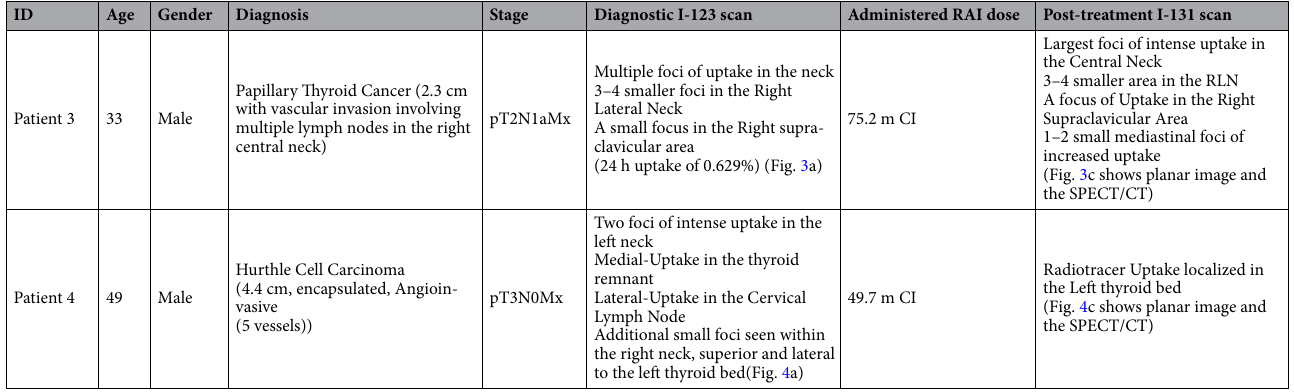
Table 3. -Shows the baseline characteristics of the two patients with thyroid